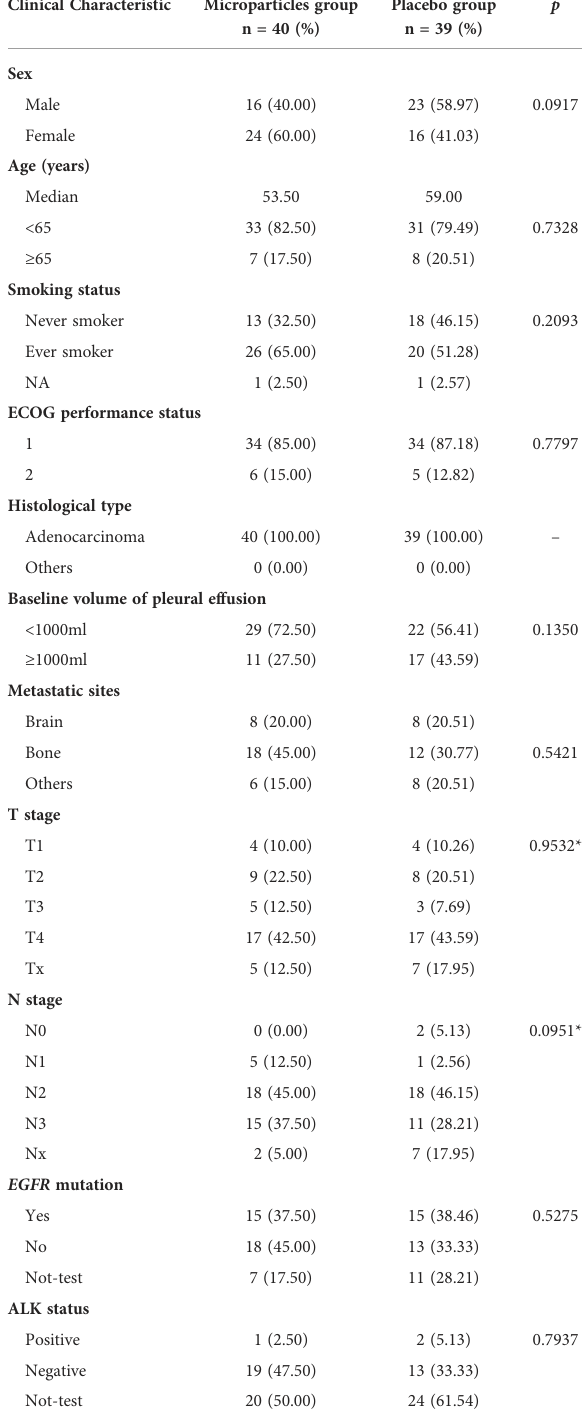
TABLE 1 Comparison of clinical characteristics between